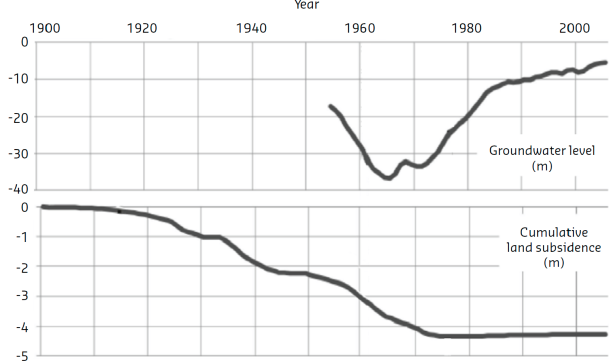
Figure 7. Land subsidence and groundwater levels in the Tokyo area (Japan), modified after Kaneko and Toyota (2011). The effect of the reduction of groundwater extraction on groundwater levels is clearly visible. Note that land subsidence completely stops 10 years after the groundwater level recovery